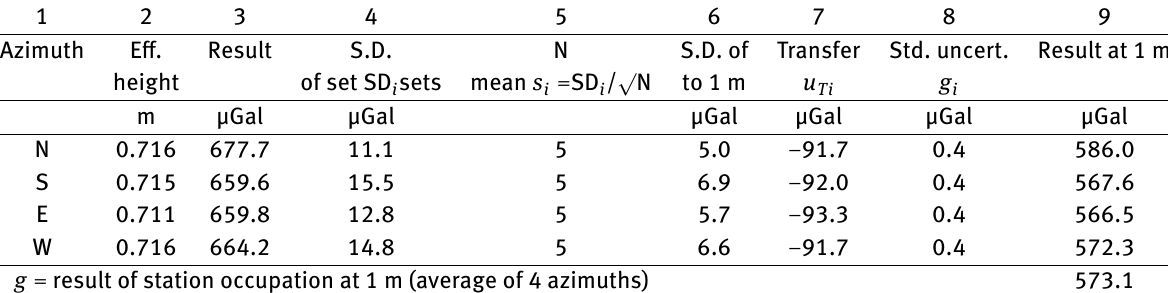
(column 8) of the correction Ti + s 2 + s 2 + s 2 )/16 + ( u 2 1 2 3 4 T 1